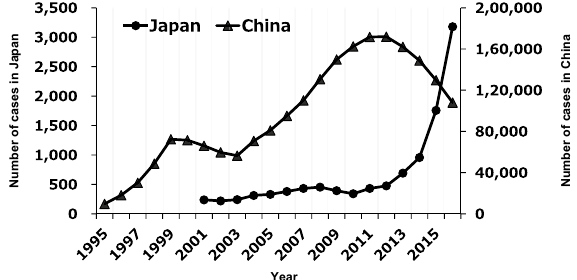
Figure 3. Number of primary and secondary syphilis cases reported in Japan and China, 1995–2016. The number of primary and secondary syphilis cases reported in Japan (plotted with circles, left scale) and in China (plotted with triangles, right scale). The original data were derived from The Japan National Tourism Organization (https ://www.jnto.go.jp/jpn/stati stics /visit or_trend s/index